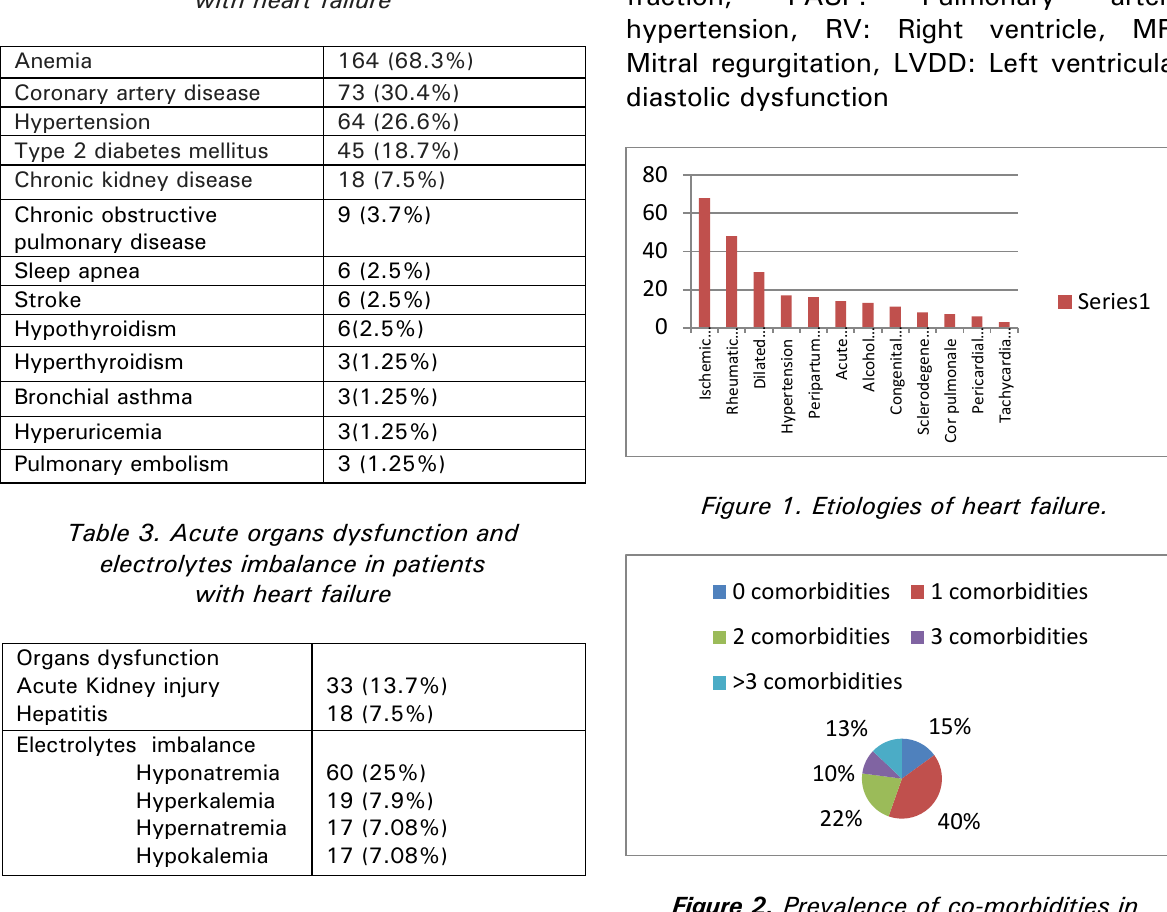
Table 2. Co-morbidities of patients